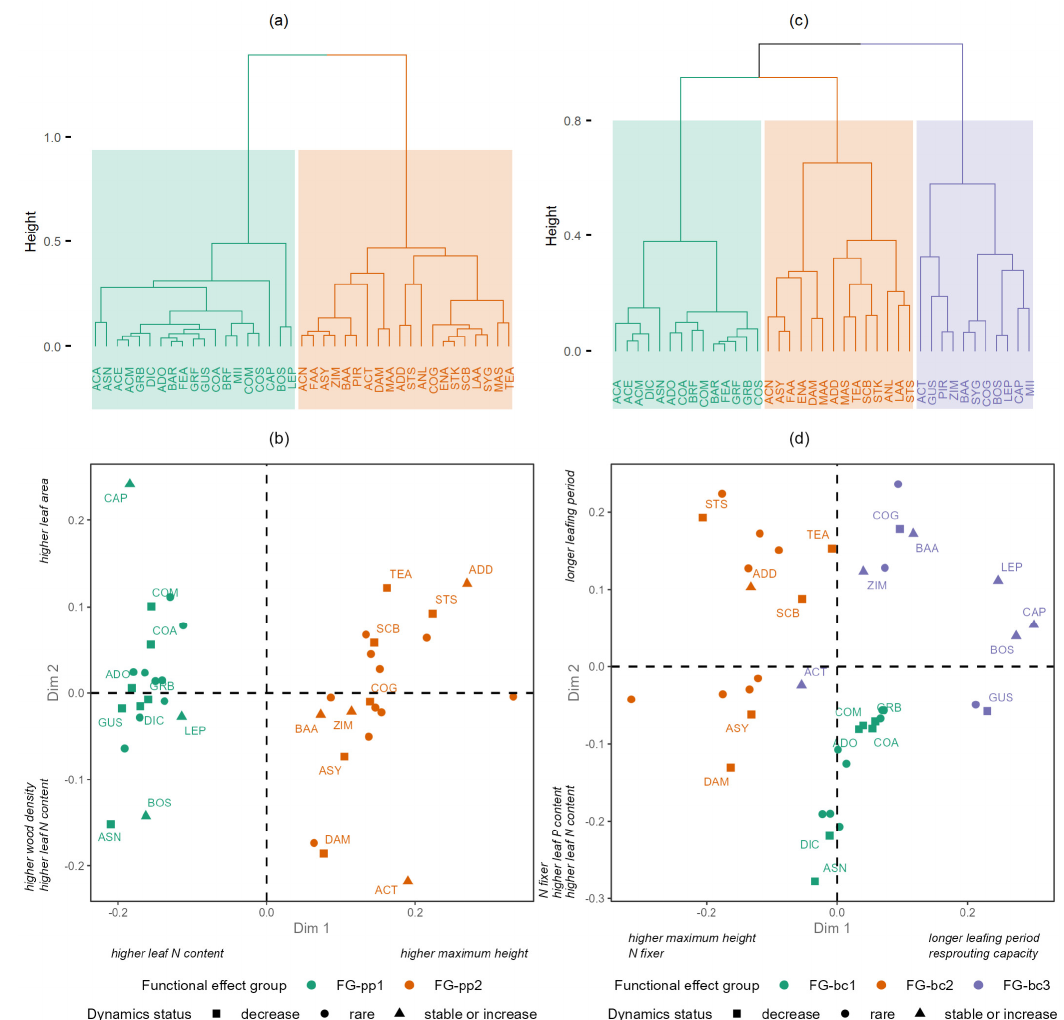
Figure 4. FG for primary productivity (FG-pp; a , b ) and for biogeochemical cycles (FG-bc; c , d ). ( a , c ) Dendrogram of the hierarchical classification (using Ward’s method) ( a ) for primary productivity and ( c ) for biogeochemical cycles. ( b , d ) Principal Coordinates Analysis of ( b ) primary productivity effect traits and ( d ) biogeochemical cycles effect traits. Traits that significantly influence the axes are indicated in italics, on the respective sides of the axes. Shapes refer to the “dynamics status” of species and colors refer to the functional groups. For the sake of clarity, we only labeled the stable/increasing and decreasing species. See Table 2 for abundant species acronyms and Supplementary File S1 for the complete list. Table 2. Key indicators of the dominant species (IVI > 5%) and minor species (1% < IVI < 5%) on hilltops and in depressions. The columns “FGpp” and “FGbc” indicate the functional group of the primary productivity and the biogeochemical cycles functions, respectively. Dynamic status high- lights the species trajectory from 1970 to 2015 [19].